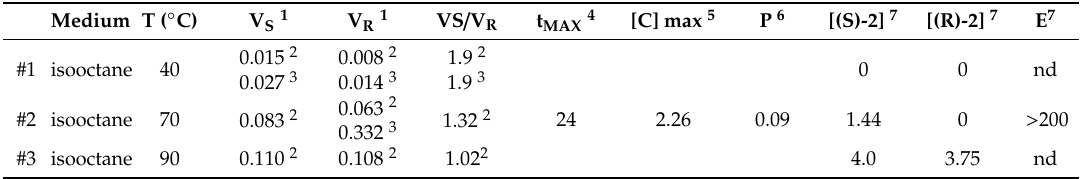
Table 1. Quantitative assessment of the ethanolysis of racemic 2-(butyryloxy)-2-phenylacetic acid ( R , S )- 1 catalyzed by BTL2 using iso octane as organic solvent at di ff erent temperatures. Medium T ( ◦ C) V S 1 V R 1 VS / V R t MAX 4 #1 isooctane